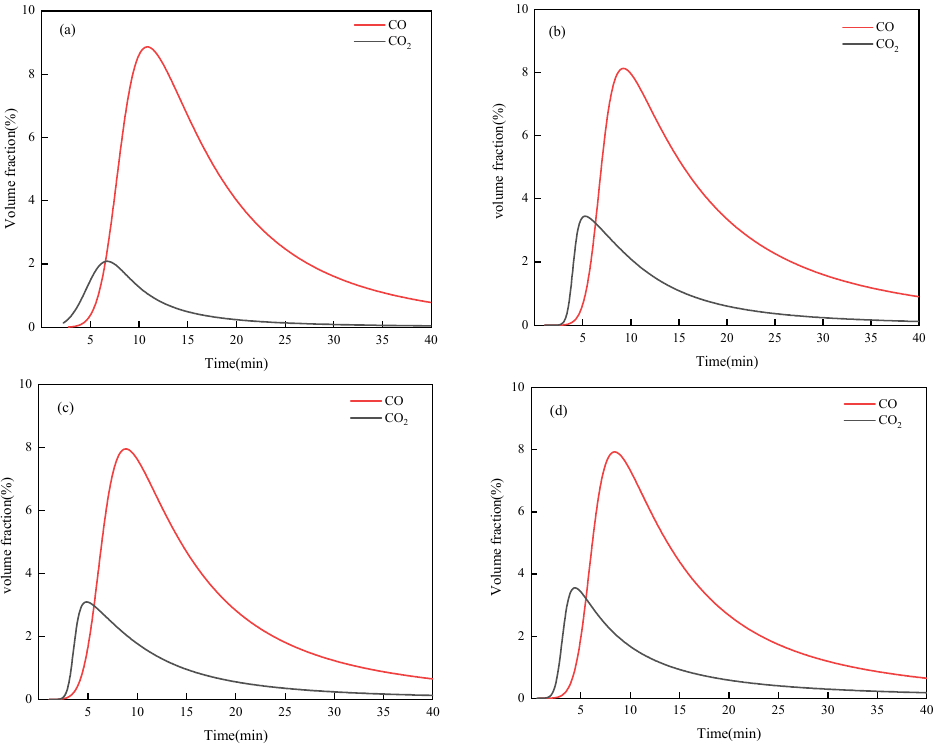
Figure 3. Effect of the added amount of CaO on the gas composition of CO 2 and CO. ( a ) 0 wt% CaO; ( b ) 5 wt% CaO; ( c ) 10 wt% CaO; ( d ) 15 wt% CaO.